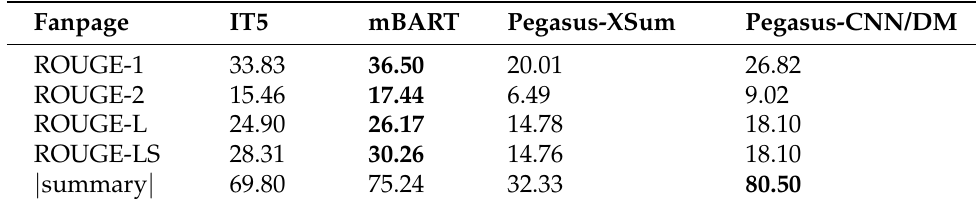
Table 4. Comparison between IT5, mBART, Pegasus-XSum, and Pegasus-CNN/DM, using the same Fanpage test set. IT5 and mBART are trained on Fanpage, while the two Pegasus models are pre- trained. | Summary | is the length of the summary in terms of the number of words. The best results reported in the table are highlighted in bold.